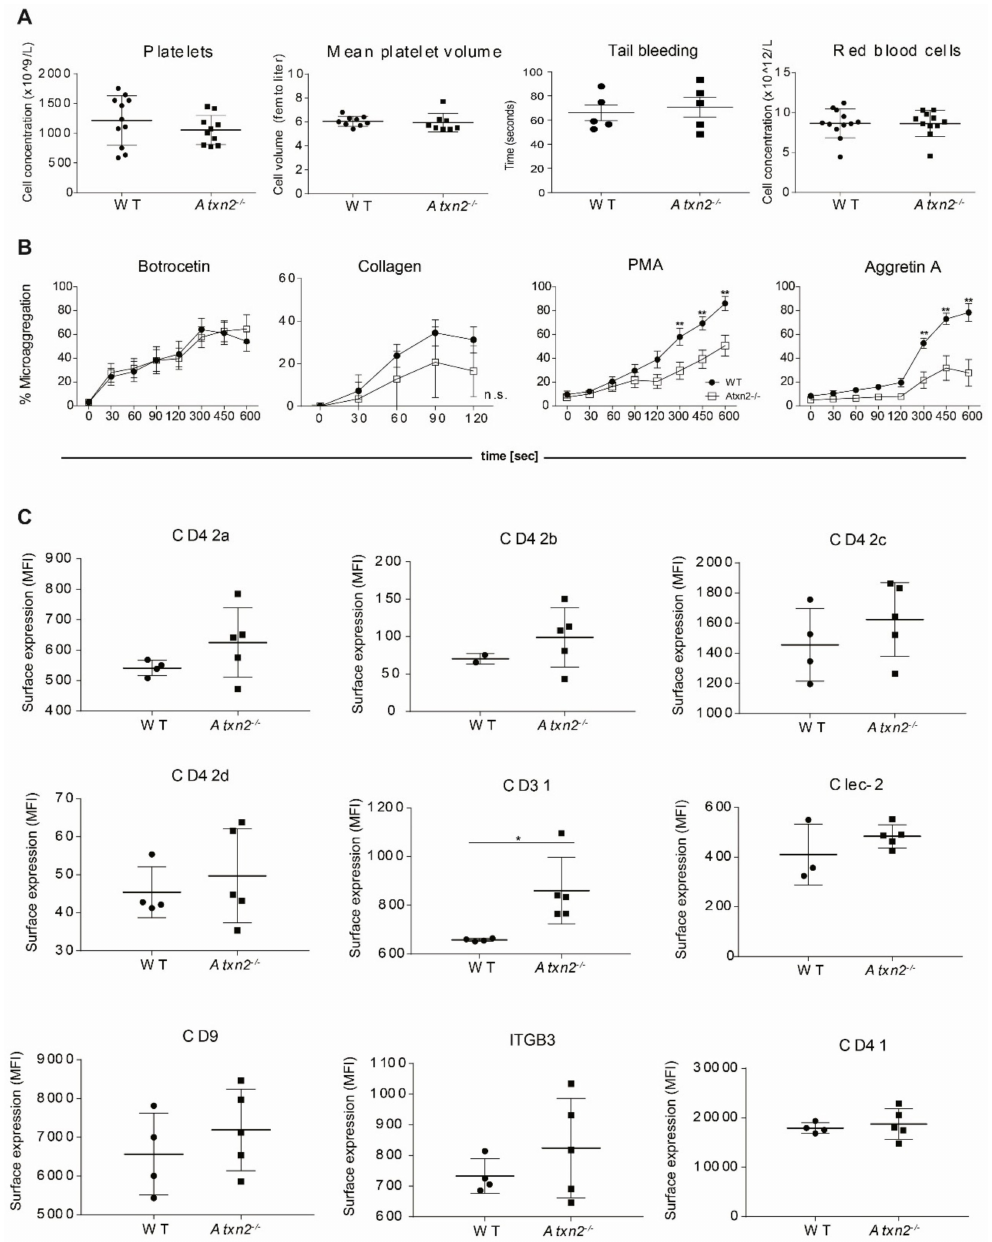
Figure 6. ATXN2 deficiency causes a platelet aggregation defect. ( A ) Concentration of platelets and platelet size, tail bleeding time and concentration of red blood cells in blood obtained by retroorbital sampling from WT and Atxn2 − / − mice, n = 8. ( B ) To measure aggregation of PLTs from WT or Atxn2 − / − mice, PLTs were isolated and split into two separate tubes, labelled with di ff erent fluorochromes, and mixed. PLTs were activated with PMA (100 ng / ml), Aggretin (300 µ M), botrocetin (10 µ g / ml) or collagen (10 µ g / ml) and the increase in double labelled aggregates (percentage) over time was measured by flow cytometry, n = 5, ** p < 0.01. ( C ) Platelet receptor surface expression measured with flow cytometry on WT or Atxn2 − / − PLTs in resting state, expression level indicated as mean fluorescent intensity (MFI), n = 5, * p <